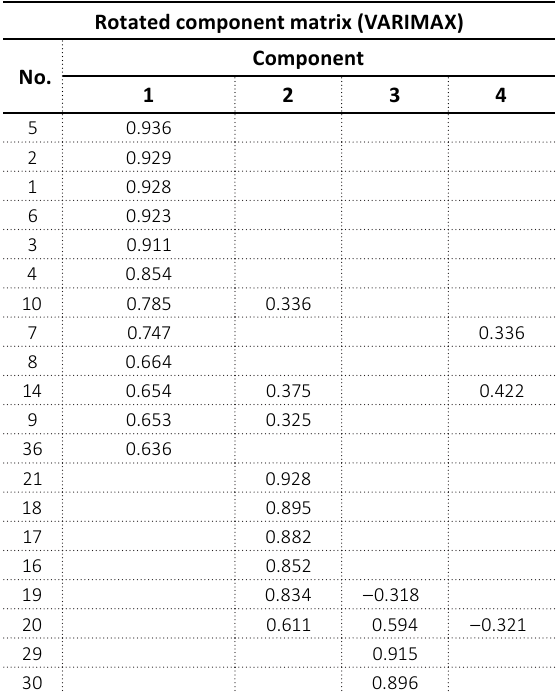
Table 5. Rotated component matrix with the VARIMAX method. Cut level: